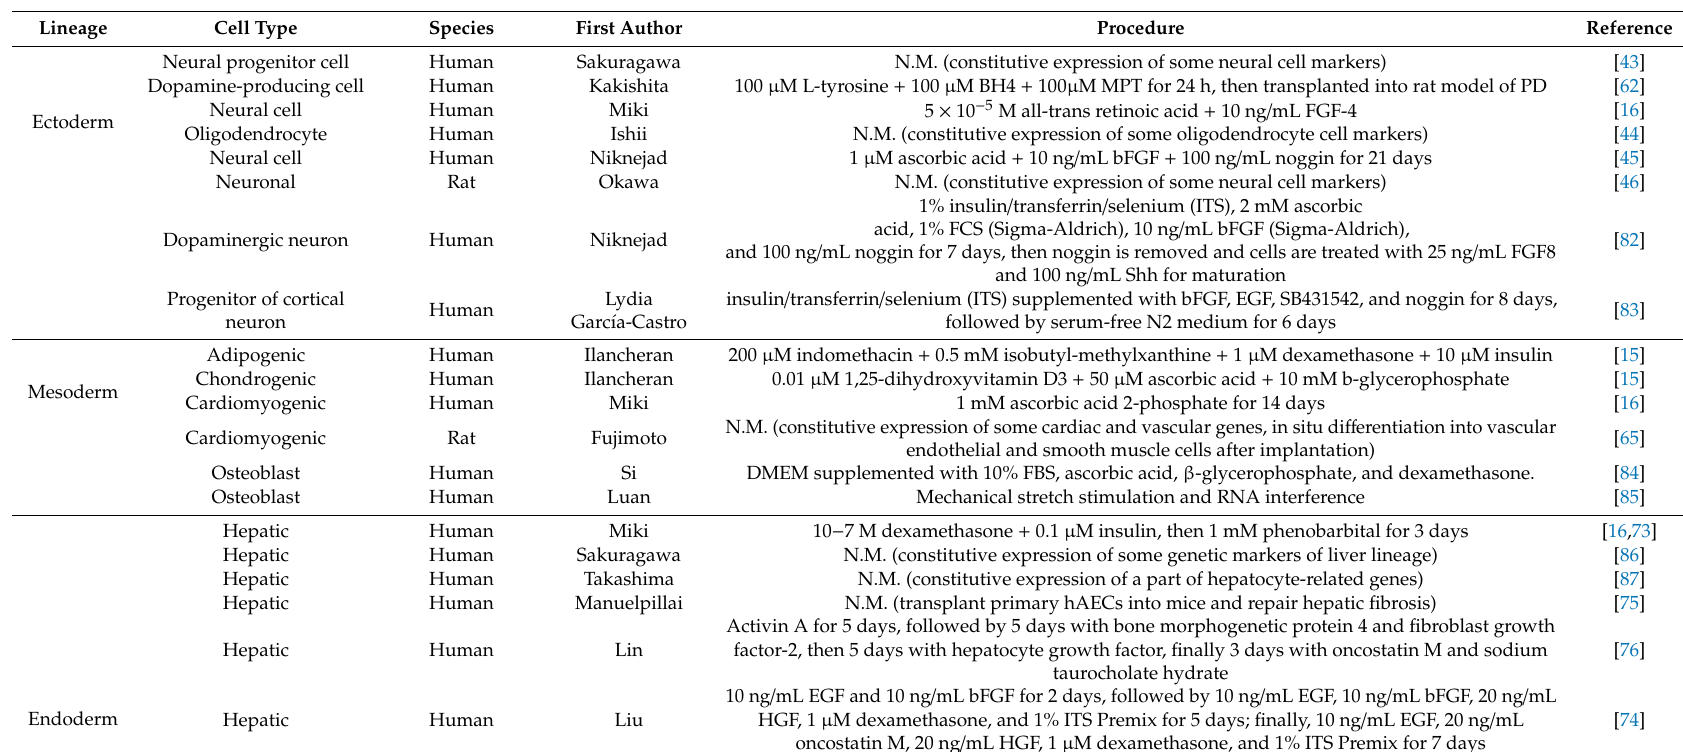
Table 2. Di ff erentiation potential of hAESCs (modified from reference